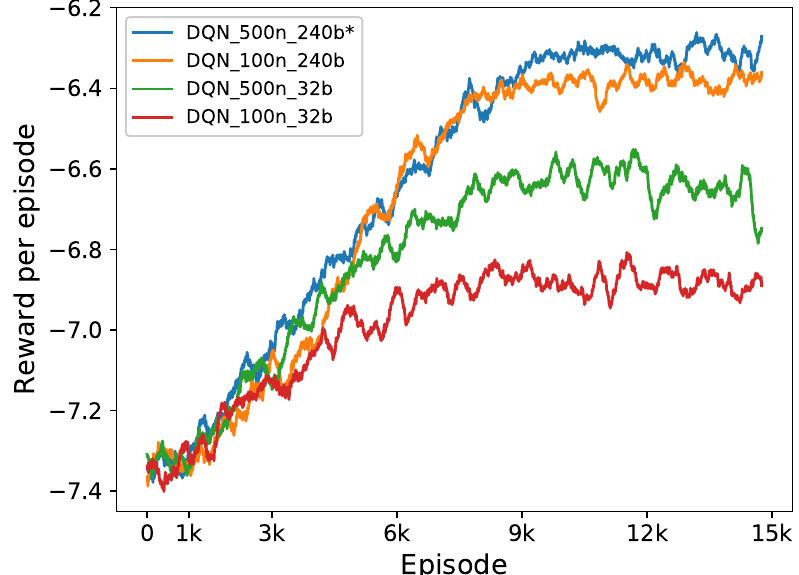
Figure 10. Learning curves obtained by proposed DRL approach using different hyper-parameters.